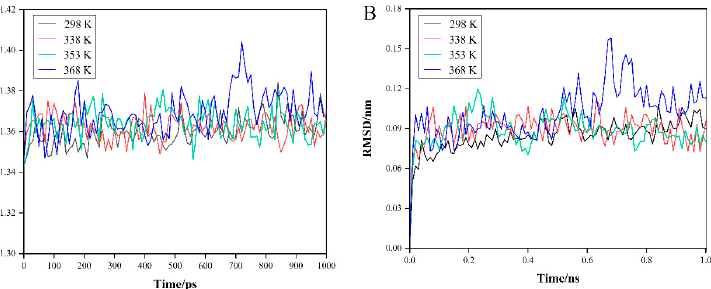
Figure 5. MD simulates the differences of α -LA in different temperature environments, and ( A ) Rg plot and ( B ) RMSD plot.